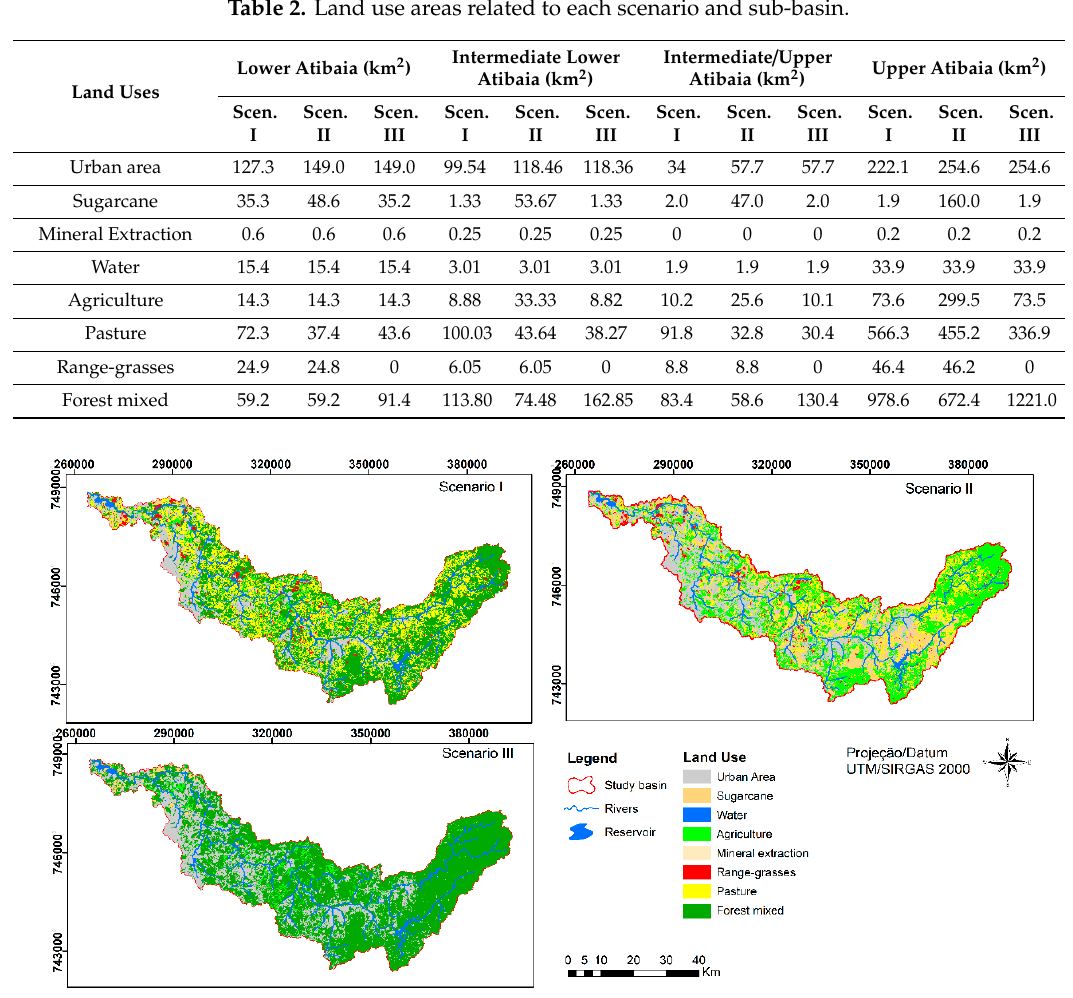
Figure 3. Atibaia river basin land use scenarios. Table 3. Calibrated curve number (CN), maximum canopy storage for each land use (CANMX) and cover and management factor (USLE_C) average values related for each